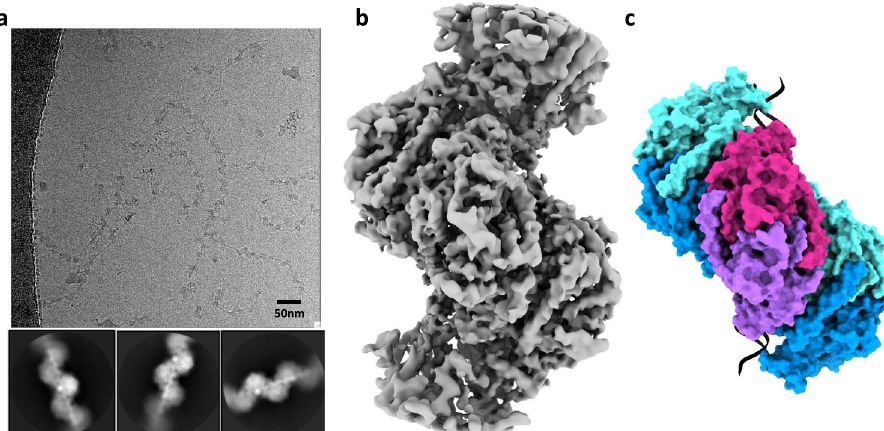
Fig. 3 Cryo-EM structure of the ParA2 vc -ATP γ S-DNA fi lament. a Representative cryo-electron micrograph of the ParA2 vc -ATP γ S-DNA fi lament (out of a 5785 micrograph dataset), with selected 2D classes underneath. b Electron potential map of the ParA2 vc ATP γ S-DNA fi lament, to 4.5 Å resolution. c Atomic model of the fi lament structure, covering 3 consecutive ParA2 vc dimers bound to DNA in cartoon representation, and in the same orientation as the map in b . Each ParA2 vc molecule is colored separately, with the central dimer in purple and magenta, and the two adjacent dimers in cyan and blue,